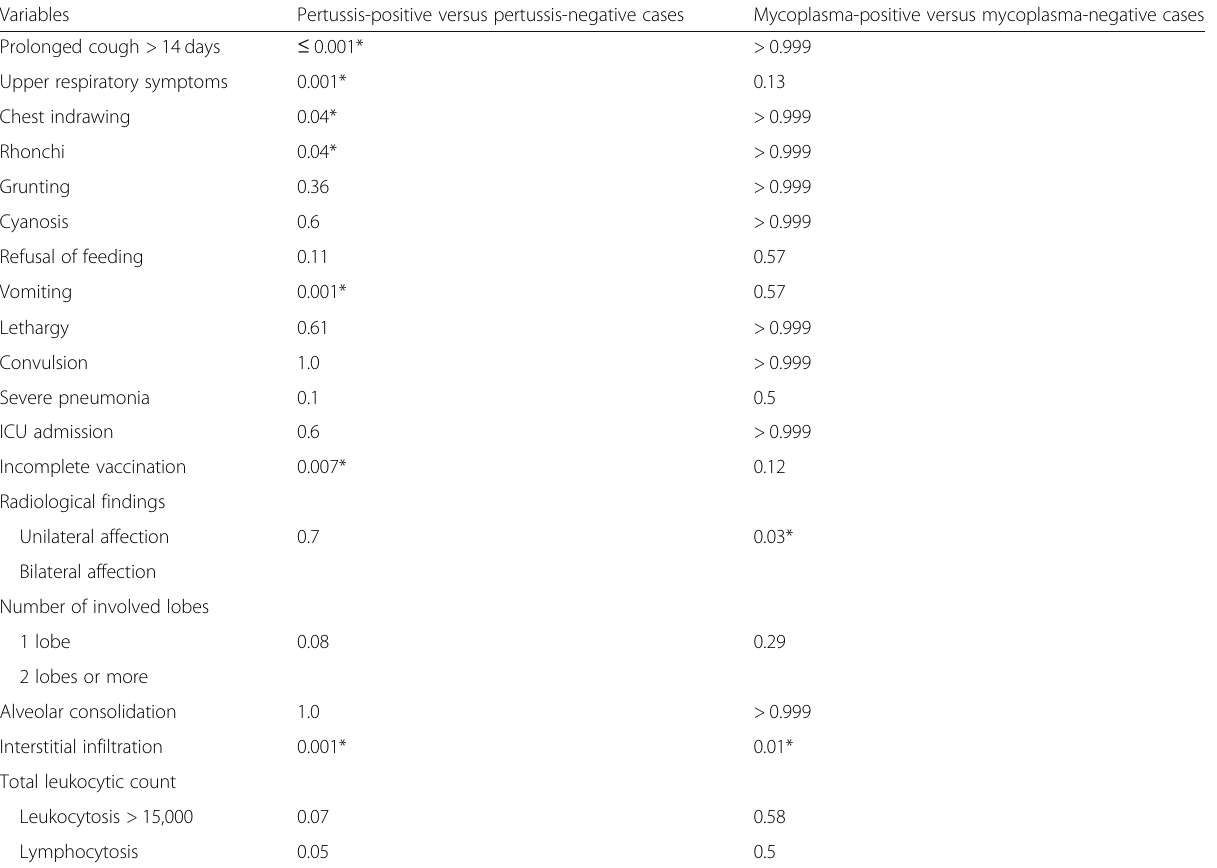
Table 4 Comparing P value of associated clinical, laboratory, and radiographic findings among positive versus negative pertussis and mycoplasma